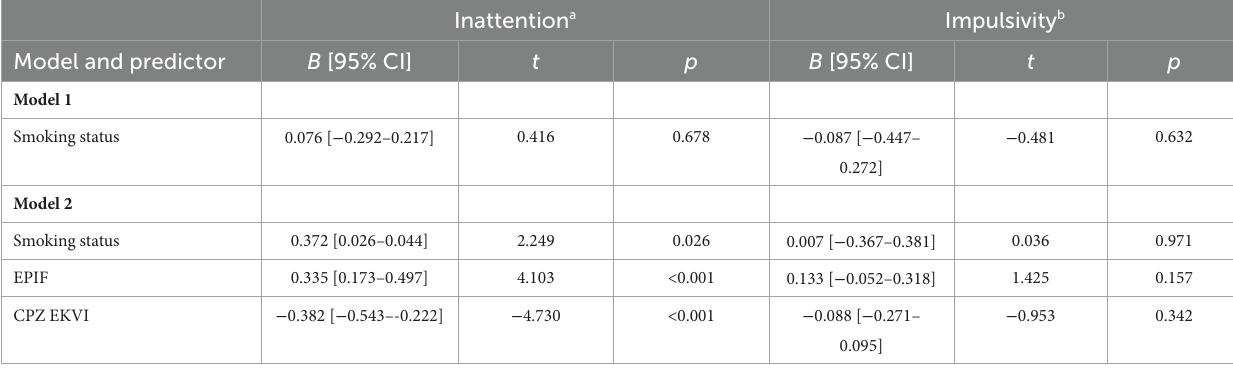
TABLE 3 Smoking status was a significant predictor of inattention when the effects of covariates were held constant, but impulsivity remained